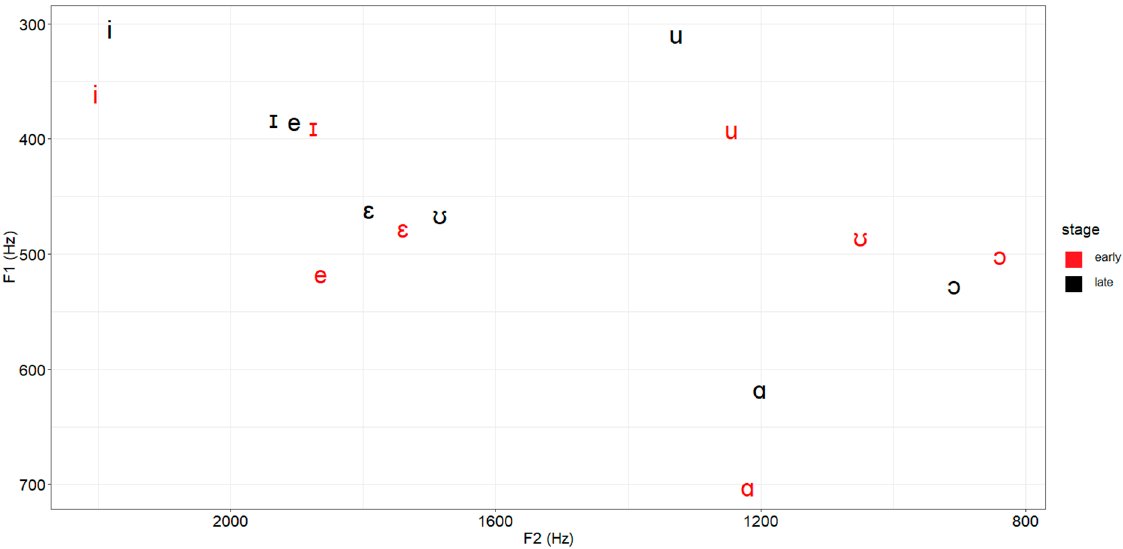
Figure 4. F1~F2 for AS’s German vowels.